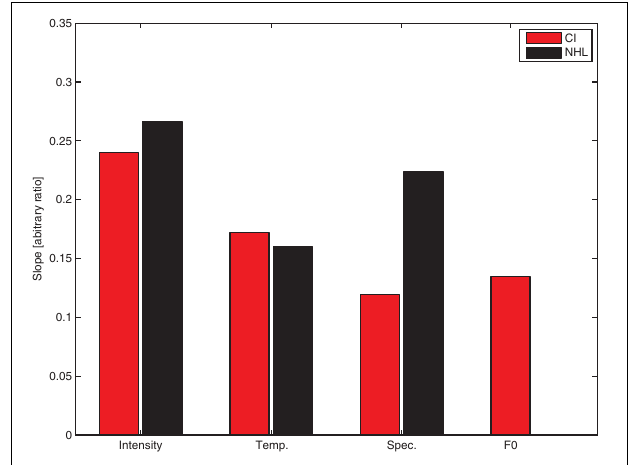
FIGURE 4 | The slope of the regression line between the physical parameter step and the MDS coordinate for the cochlear implant users in each condition in the current study (red bars), compared with the same results from our previous study in normal hearing listeners (Marozeau et al., 2013, black bars). The F0 was not tested in the normal hearing listeners (NHL).